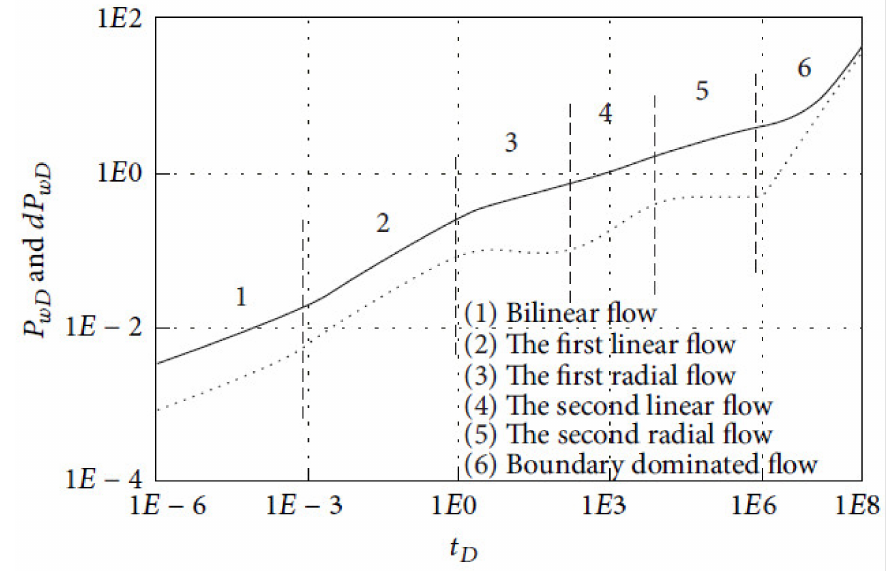
Figure 3. 6 Flow Regimes for a Multi-fractured Horizontal Well. Equation (7). Partial Differential Equation for Fracture (Unsteady